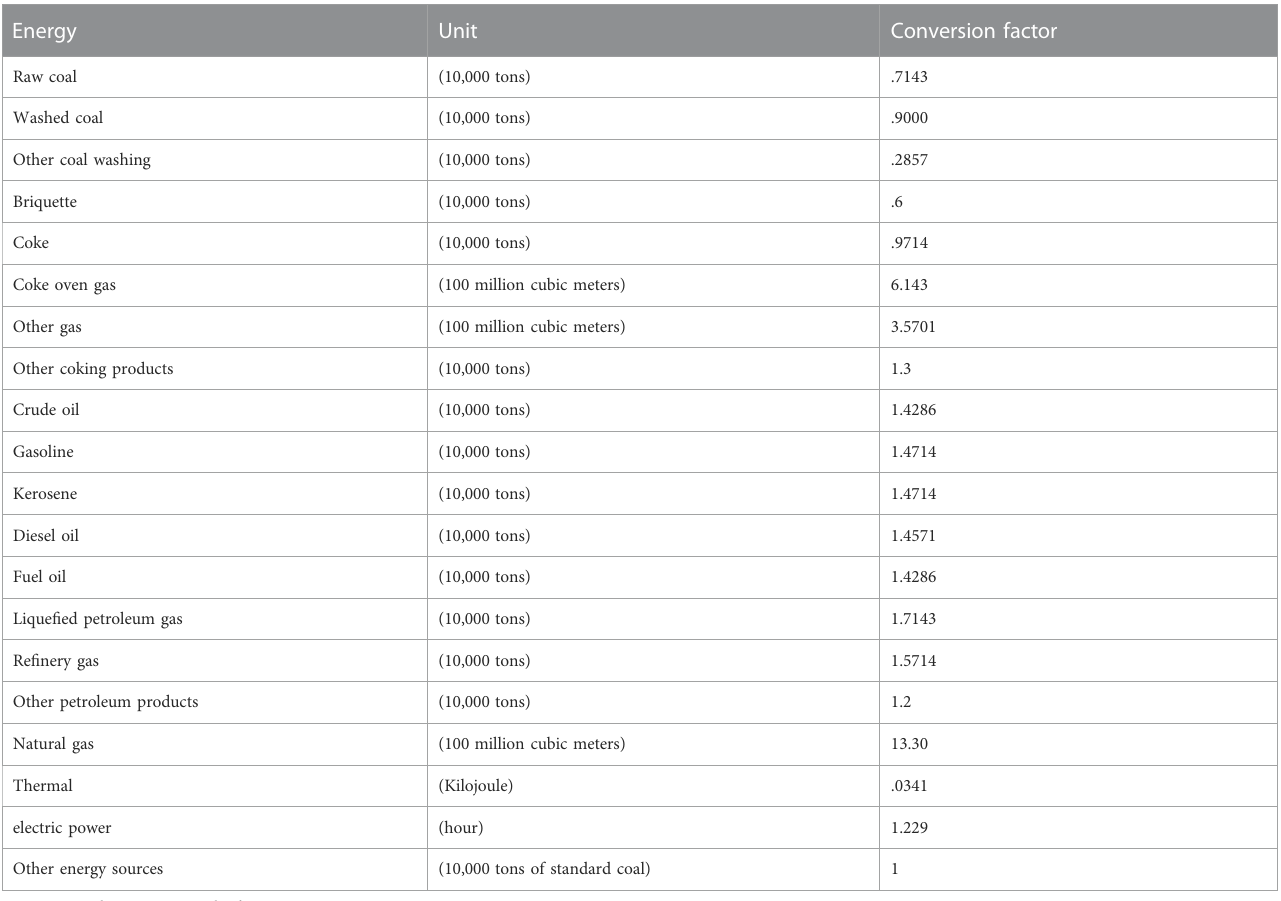
TABLE 1 Conversion factor of different energy